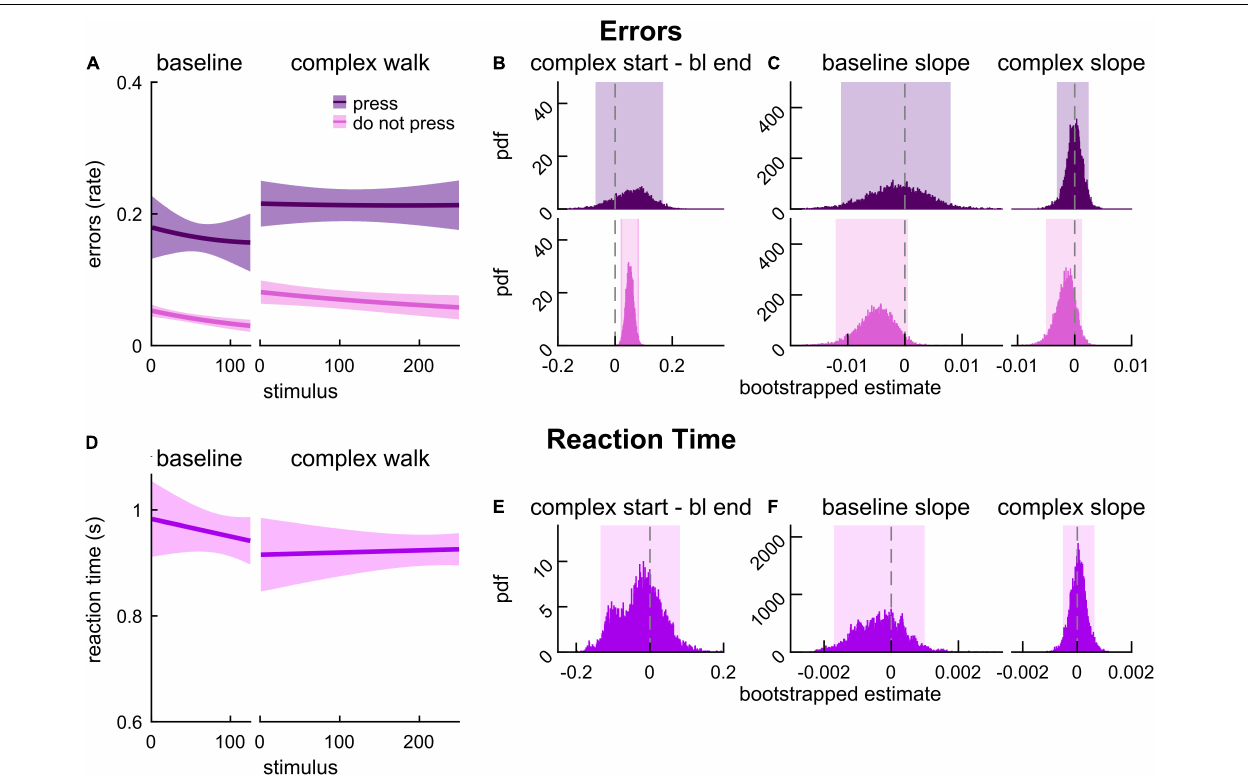
FIGURE 6 | 2-back performance during baseline and complex walking in late middle-aged adults. (A) Logistic fits (mean and shaded SE) of the error rate in response to press stimuli (dark purple) and do not press stimuli (pink) during an auditory 2-back task. (B) PDF of the differences in error rate estimates between the start of complex walking (first value) and the end of baseline (last value) from logistic model fits. (C) PDF of slope estimates for logistic fits of error rate in baseline and complex walking. (D) Linear fits (mean and shaded SE) of reaction time. (E) PDF of the differences in reaction time estimates between the start of complex walking (first value) and end of baseline (last value) estimated from linear model fits. (F) PDF of slope estimates for linear fits of reaction time in baseline and complex walking. Lighter shaded areas of PDF plots indicate the 95% CI; when applicable, darker shaded areas of PDF plots indicate the correction to the CI for 3 comparisons. SEs, PDFs, and CIs were obtained through bootstrapping. Error rate with do not press stimuli only declines with complex walking in late middle-aged